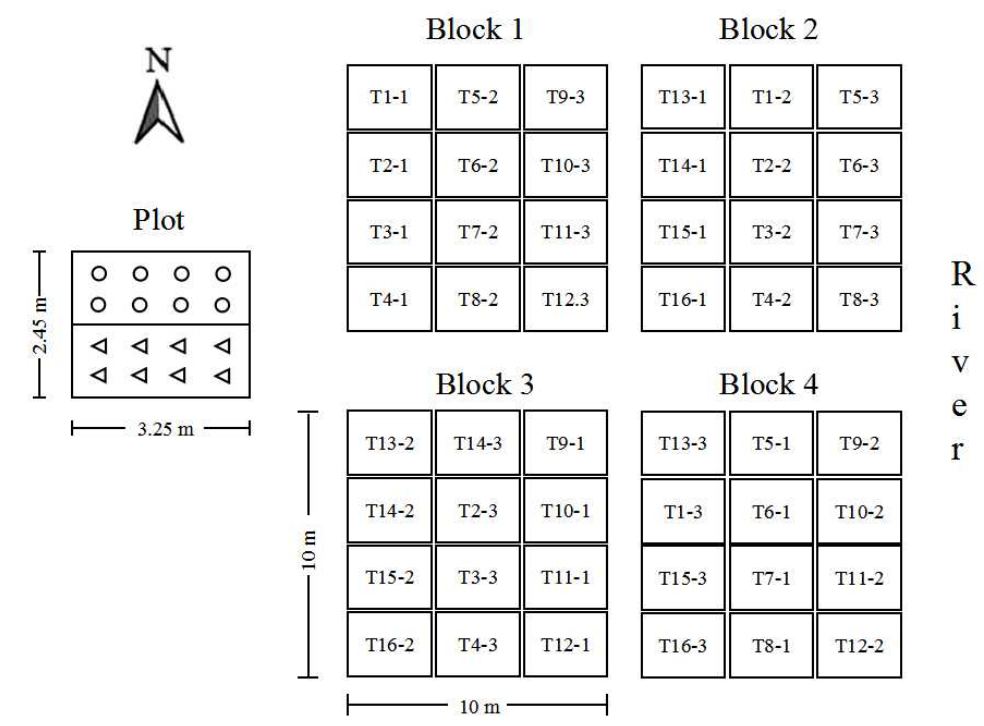
Figure 1. Experimental design of different bioaugmentation measures and planting modes. Note: the circle represents F. chinensis ; the triangle represents S. matsudana × alba . Table 1. Treatments of orthogonal array test.